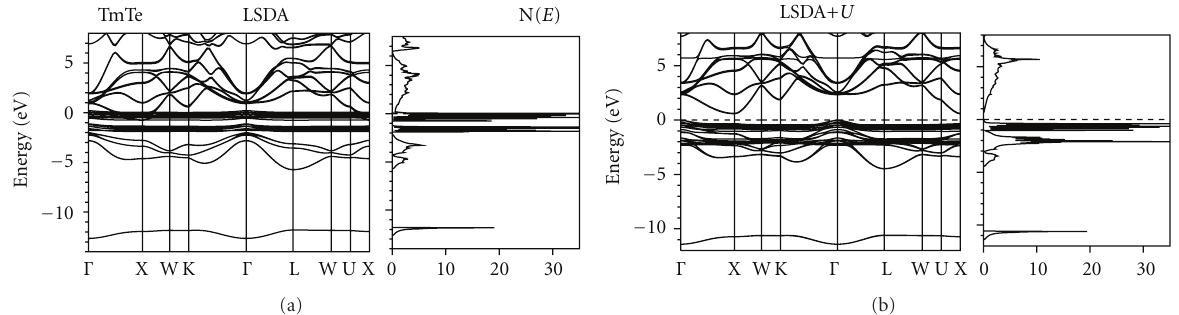
Figure 68: Self-consistent fully relativistic, spin-polarized energy band structure and total DOS (in states/(unit cell eV)) calculated for TmTe [384].